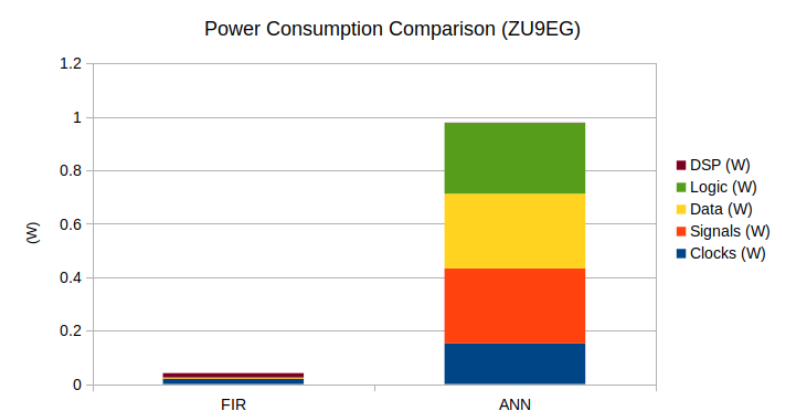
Figure 18. Power consumption comparison between both